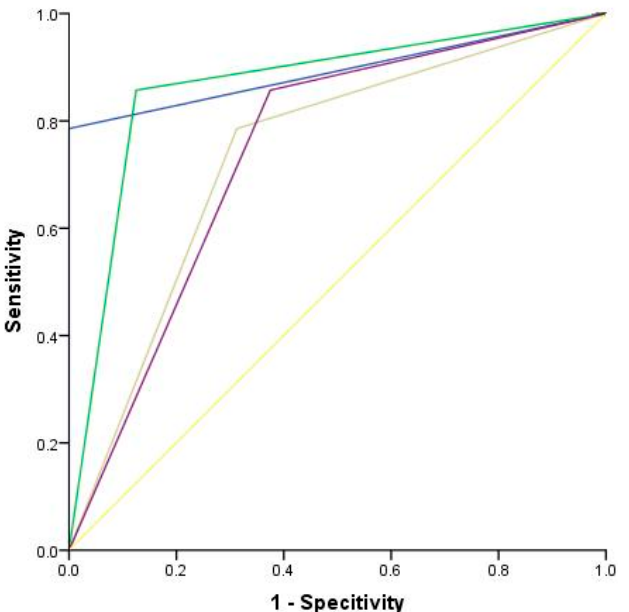
Figure 3. ROC curves for rFA and FA Laterality Index within 3 months post-stroke for prediction of lower-Extremity motor outcome by LE-PG ≤ 1 after 1 year. The areas under the curve were both higher for rFA (blue line) and FA laterality index (green line) obtained in MCP than that in CP (0.893 vs. 0.737, 0.866 vs. 0.741, respectively). The purple and crown line represent rFA and FA laterality index obtained in CP respectively. The straight light-yellow line represents 50% of the area under the curve.